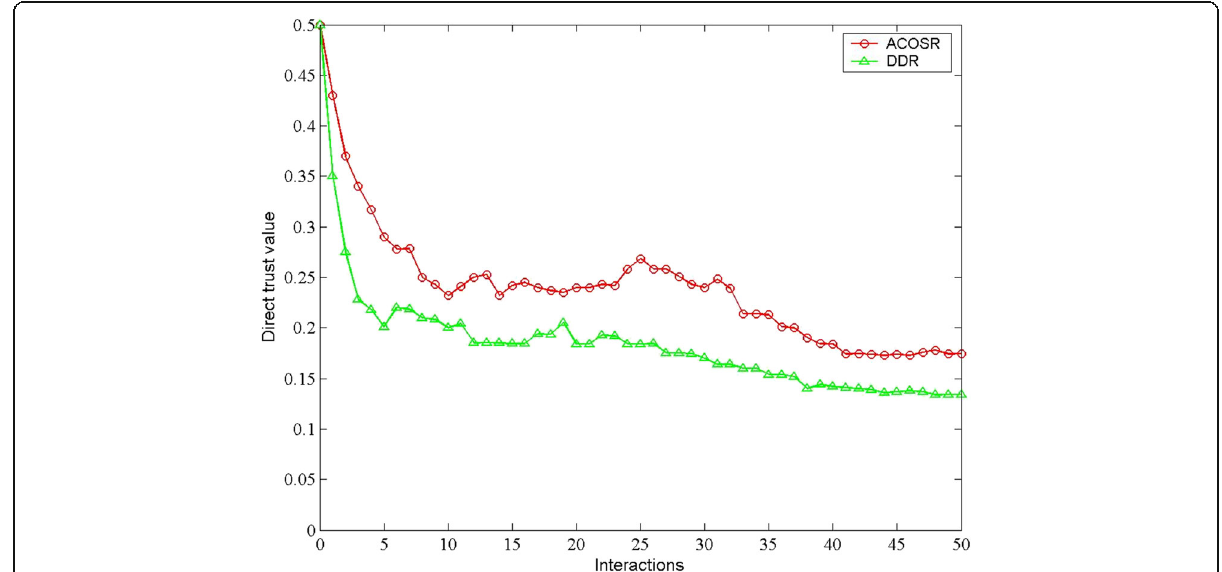
Fig. 4 Comprehensive trust value in the case of malicious node ’ s